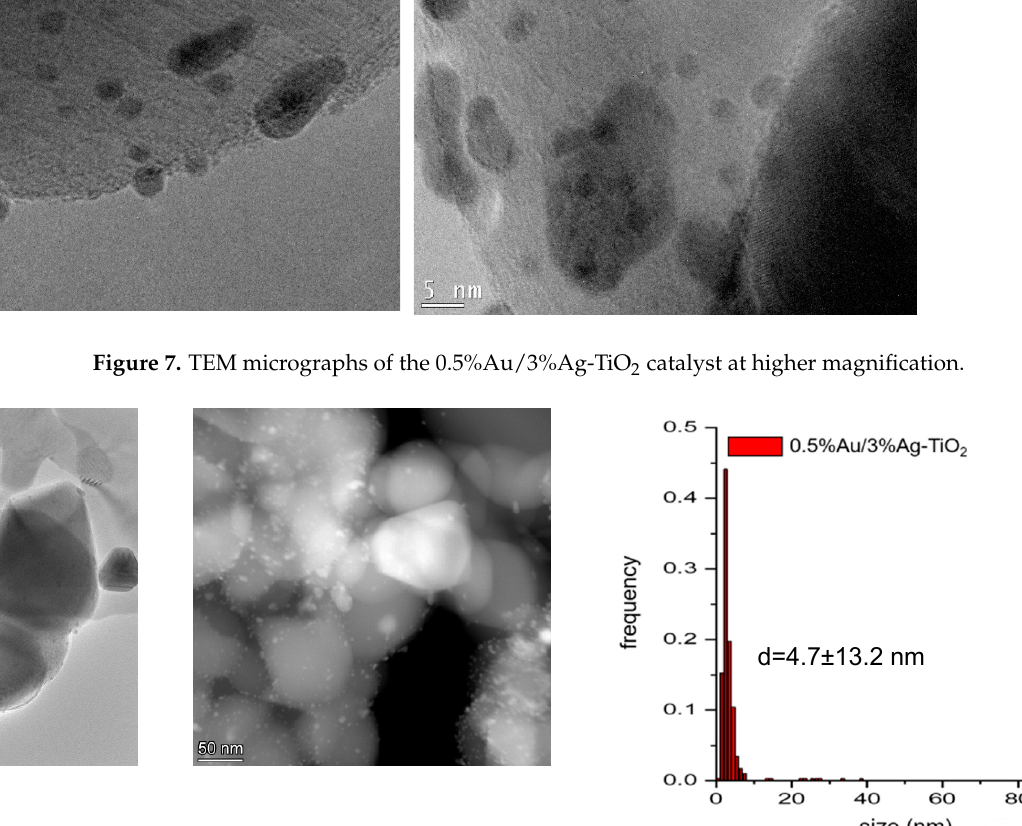
Figure 7. TEM micrographs of the 0.5%Au/3%Ag-TiO 2 catalyst at higher magnification.